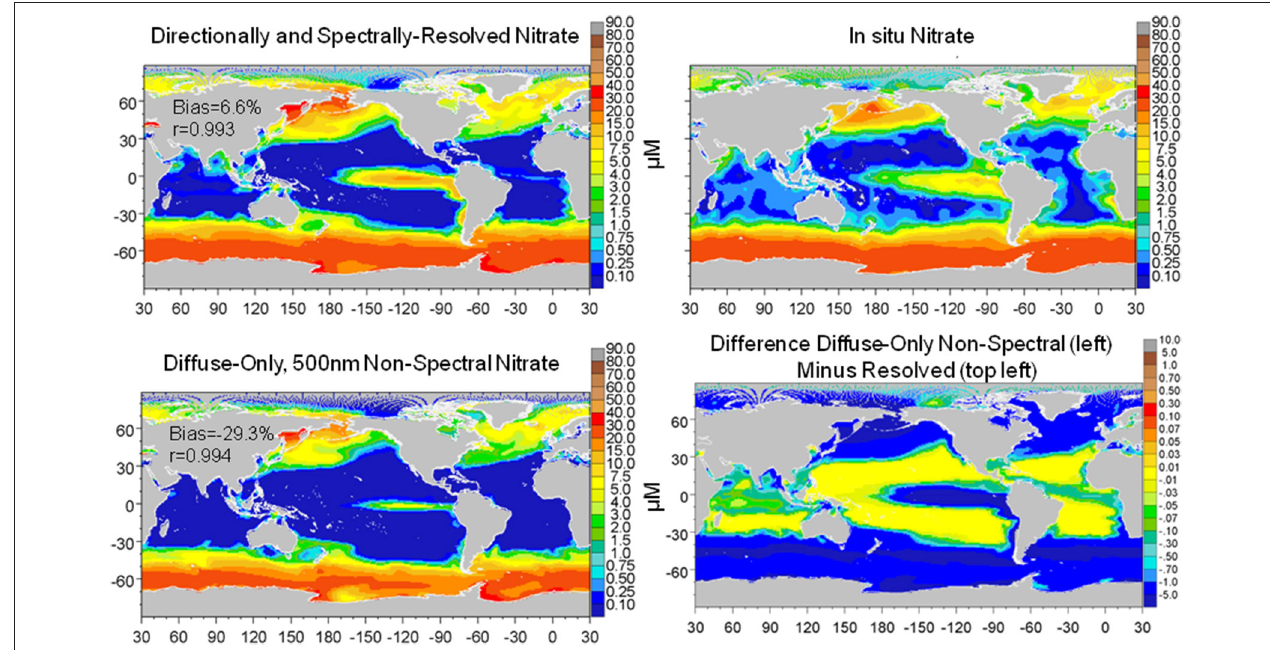
FIGURE 9 | Global distribution of nitrate from the directionally and spectrally-resolved model, in situ data and the diffuse-only, 500 nm non-spectral simulation and the difference. Statistics on global distributions compared to in situ data are shown in the plots. The correlation for both models is statistically significant at P < 0.05.